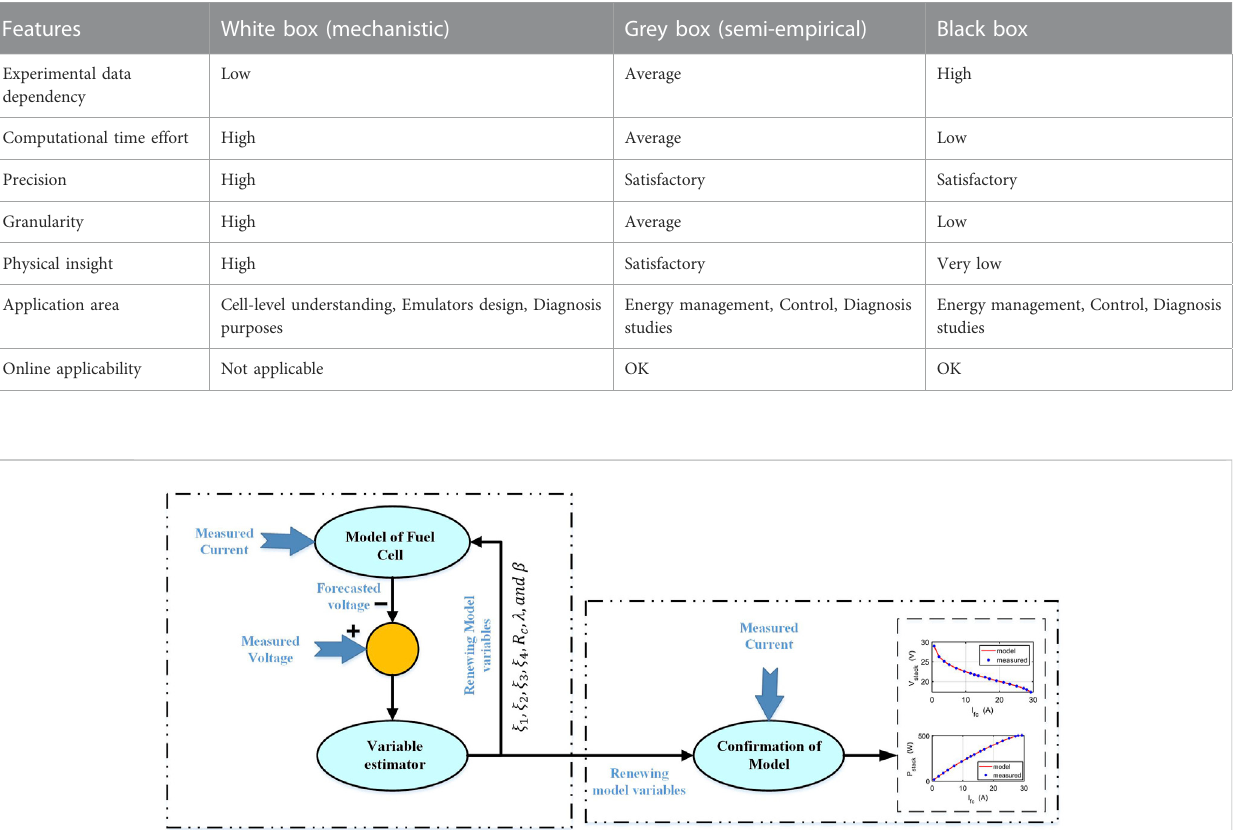
TABLE 2 Different types of the PEMFC models.